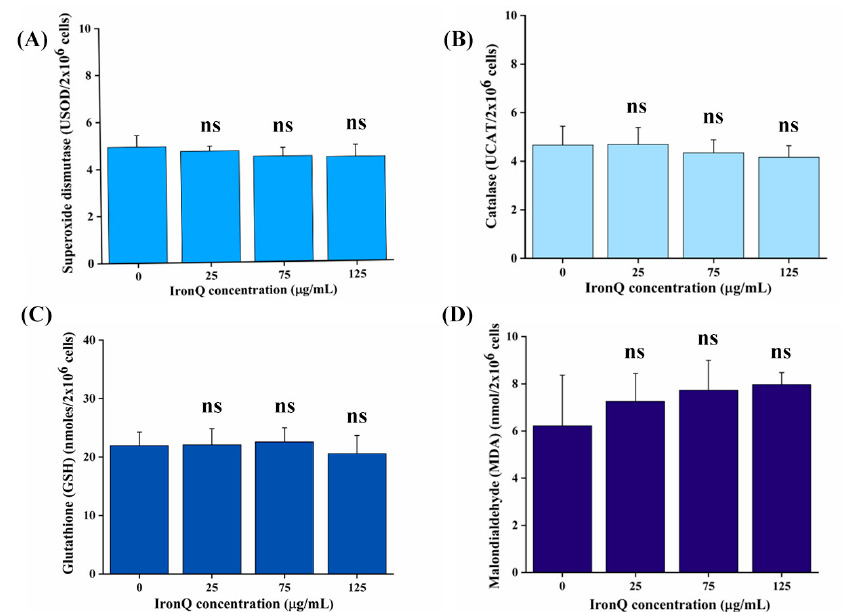
Figure 3. Antioxidant response and the lipid peroxidation level after PBMC labeling with IronQ. ( A ) SOD activity in PBMCs labeled with IronQ at different concentrations for an incubation period of 24 h. ( B ) CAT activity in PBMCs treated with different concentrations of IronQ. ( C ) GSH level in PBMCs after labeling with IronQ at different concentrations for an incubation period of 24 h. ( D ) Malondialdehyde (MDA) level after PBMC labeling with IronQ at different concentrations for an incubation period of 24 h. Data are expressed as mean ± SD of eight independent samples. No significant difference in antioxidant enzyme levels or MDA levels were observed in PBMCs treated with different concentrations of IronQ groups, compared to the control. ns is not significantly different from the control. SOD: superoxide peroxidase; CAT: catalase; GSH: glutathione; PBMCs: peripheral blood mononuclear